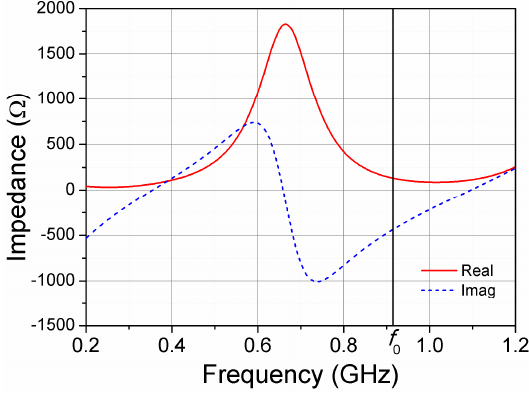
Figure 3 . Simulated input impedance of the wire antenna. Figure 3. Simulated input impedance of the wire